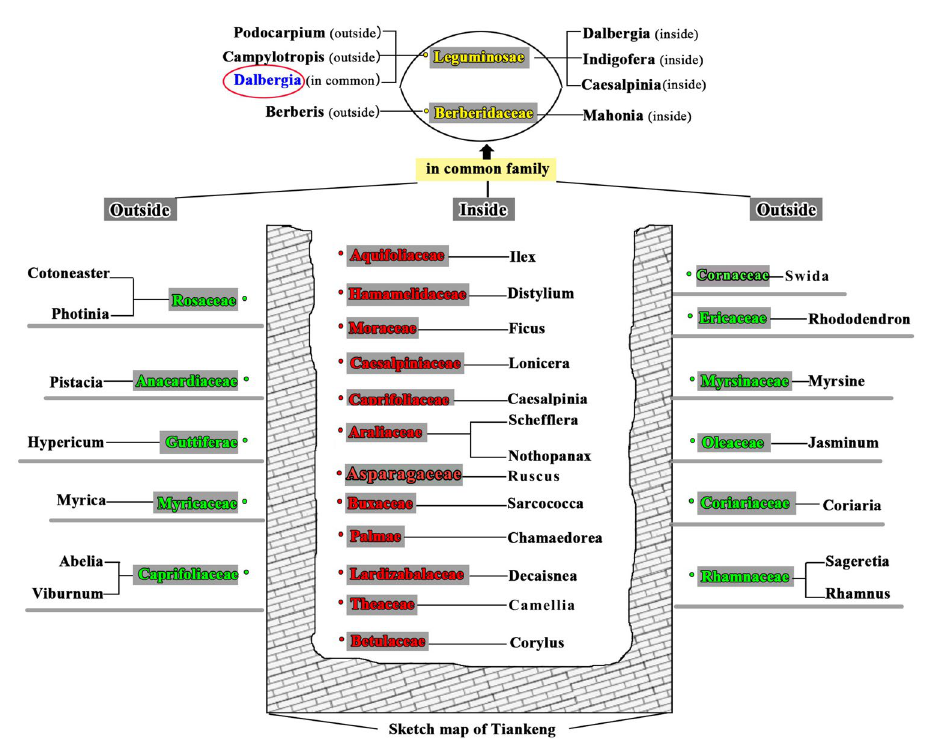
Figure 2. Shrub comparison between inside-tiankeng and